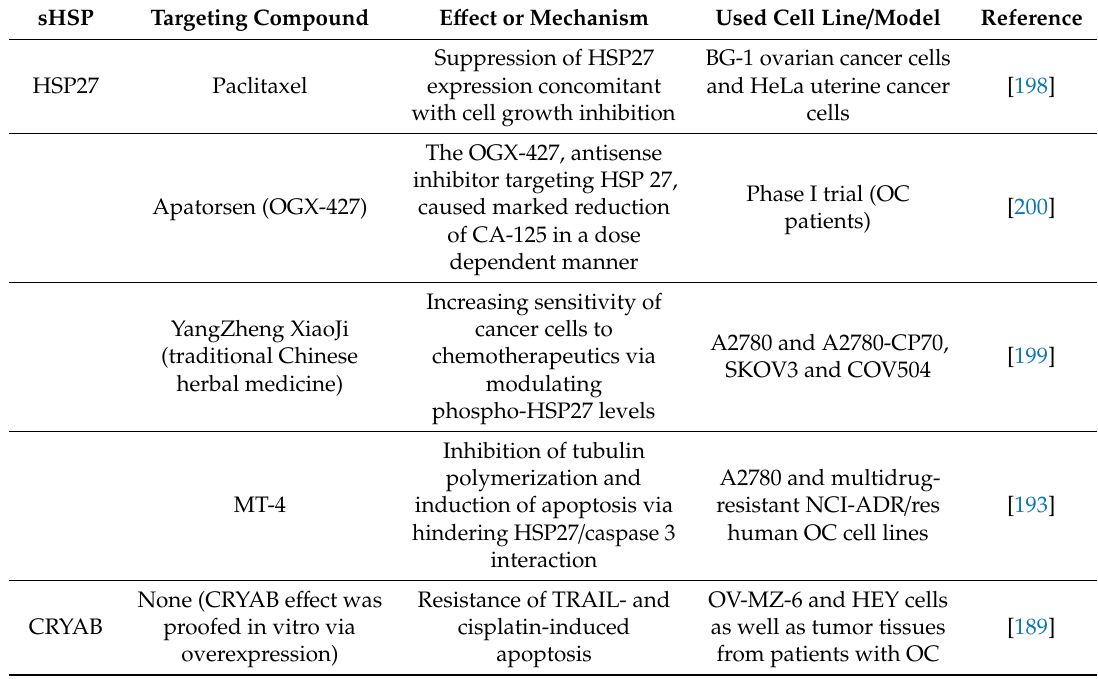
Table 4. Summary of pre-clinical and clinical studies targeting HSP27 in